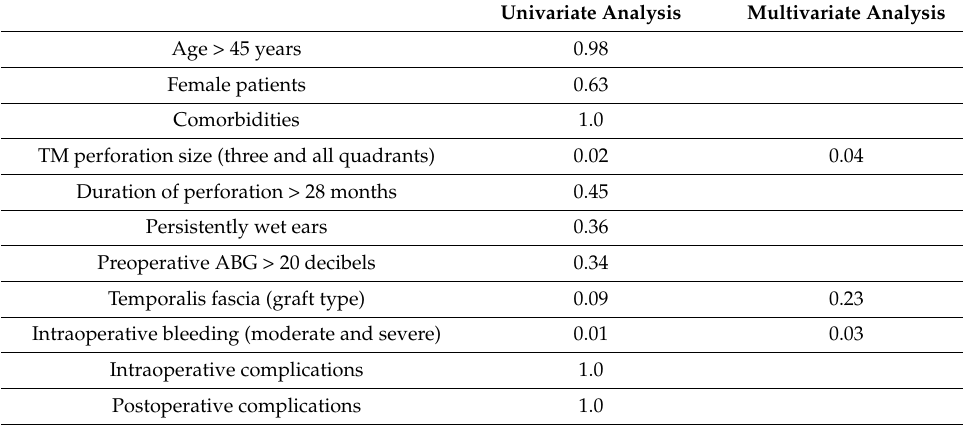
Table 2. Univariate and multivariate analysis of outcome (i.e., postoperative TM perforation) in chronic otitis media patients treated with